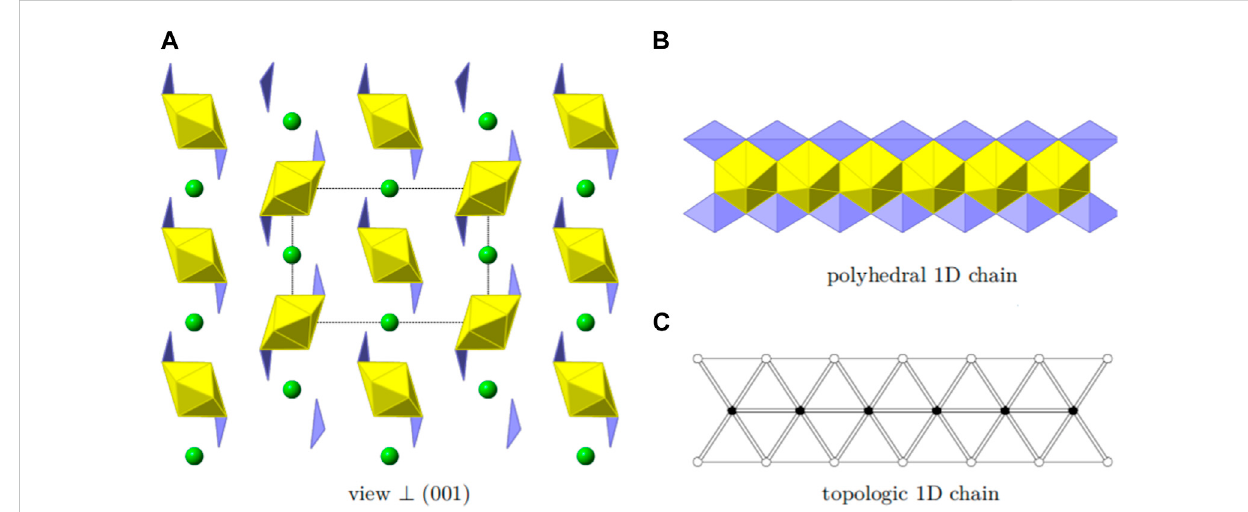
FIGURE 5 StructuralandtopologicdepictionofSr[(UO 2 )(TeO 3 ) 2 ].In (A) asideviewofthestructurecanbeseen.Theunit-celloutlineisshownindashed-lines. In (B) , chains of [(UO 2 ) (TeO 3 ) 2 ] 2 − propagating into the [001] direction are shown. The according topology is depicted in (C)